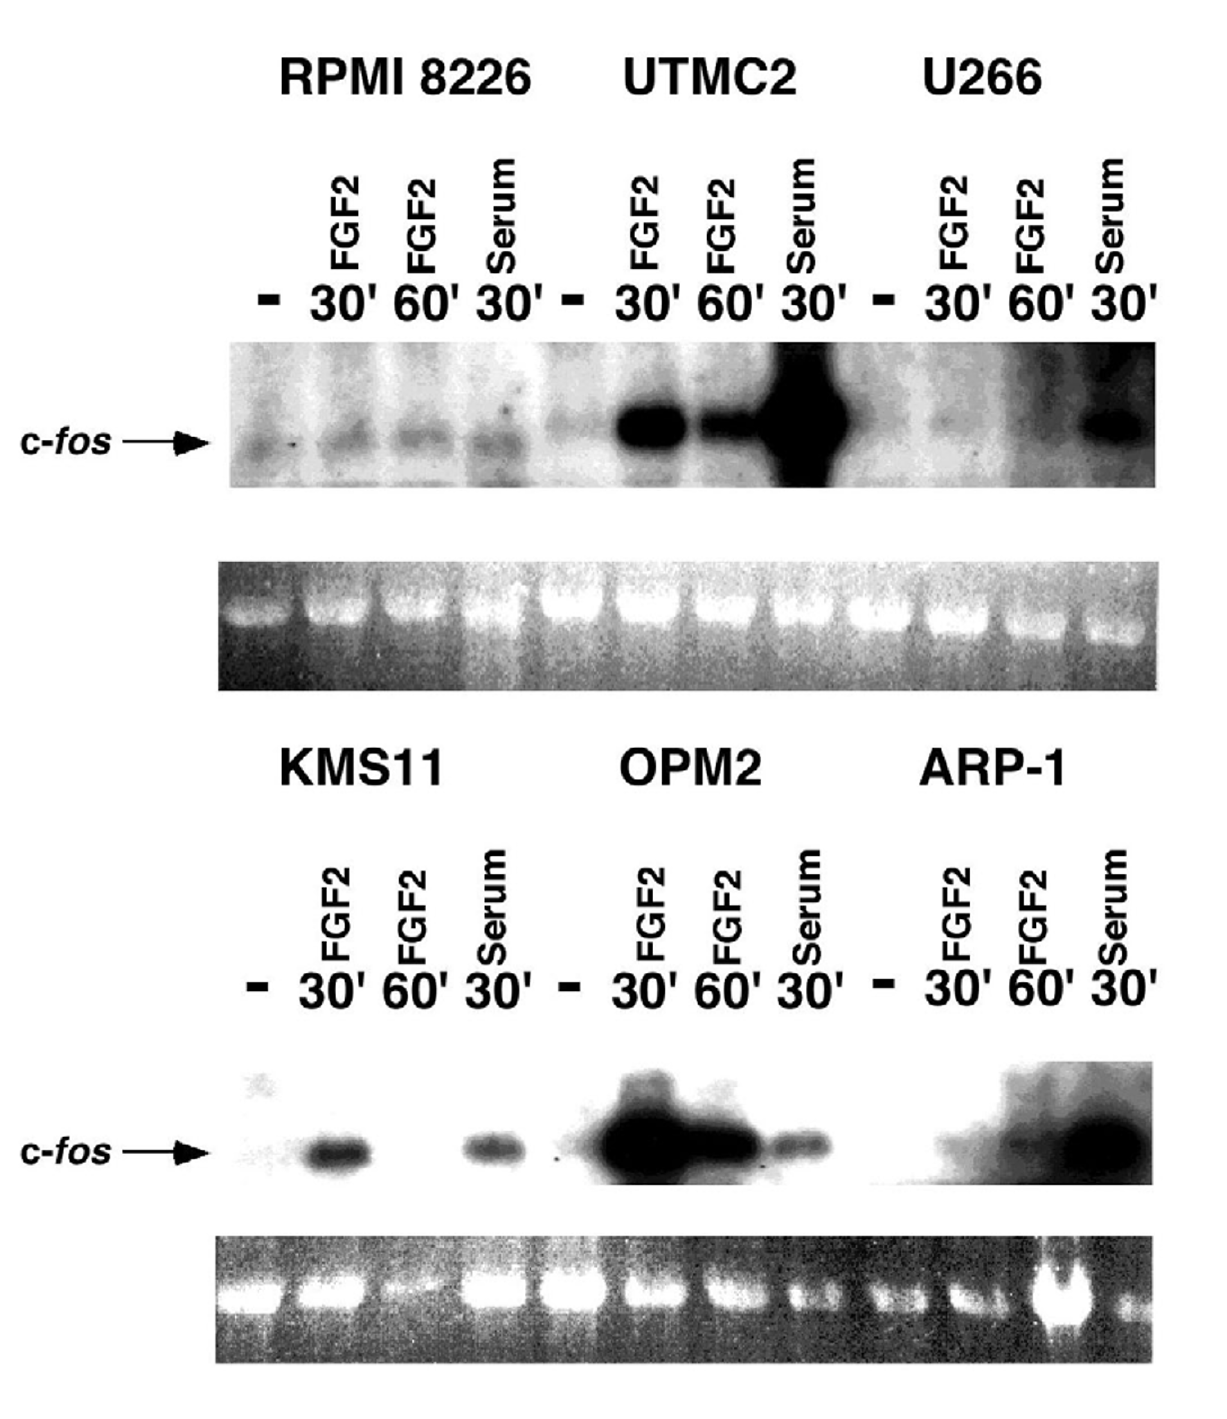
Figure 4 FGF Signaling Induces fos in Myeloma Cell Lines containing t(4;14). Cell lines were cultured in serum free medium for twenty four hours and FGF2 (50 ng/ml) or 10% serum was added. Total RNA was isolated and the expression of c- fos was measured at the indicated times. Ethidium bromide stain of 28 S RNA is